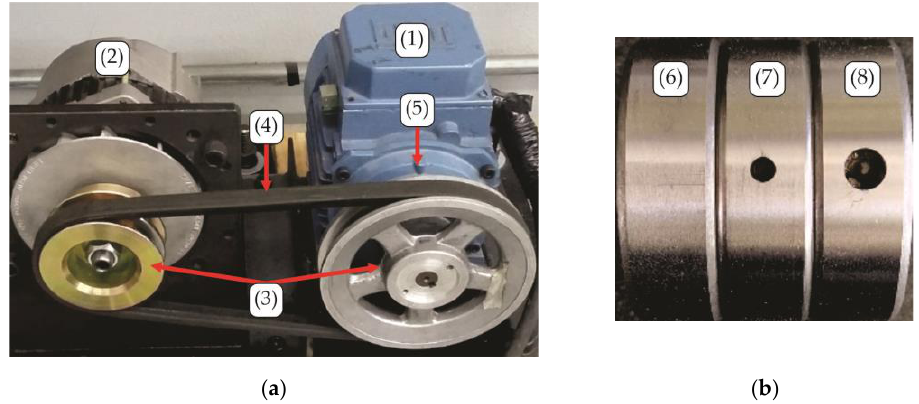
Figure 5. Experimental setup: ( a ) test bench; ( b ) rolling bearings conditions. The considered elements were the (1) induction motor, (2) alternator as the motor load, (3) output shaft pulleys, (4) transmission belt, (5) location of the bearing under analysis in the frontal support of the shaft, (6) bearing with a healthy outer race, (7) bearing with a 3 mm hole in the outer race, and (8) bearing with a 5 mm hole in the outer race.